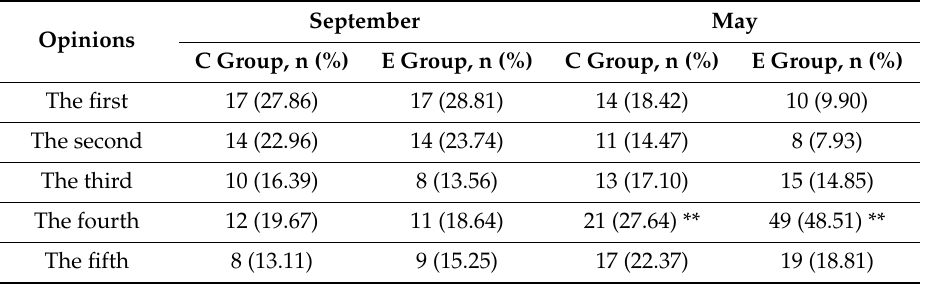
Table 2. The number of students in control (C) and experimental (E) groups who solved three problems and chose the first, second, third, fourth or fifth opinion in the control (C) and experimental (E) groups in September and